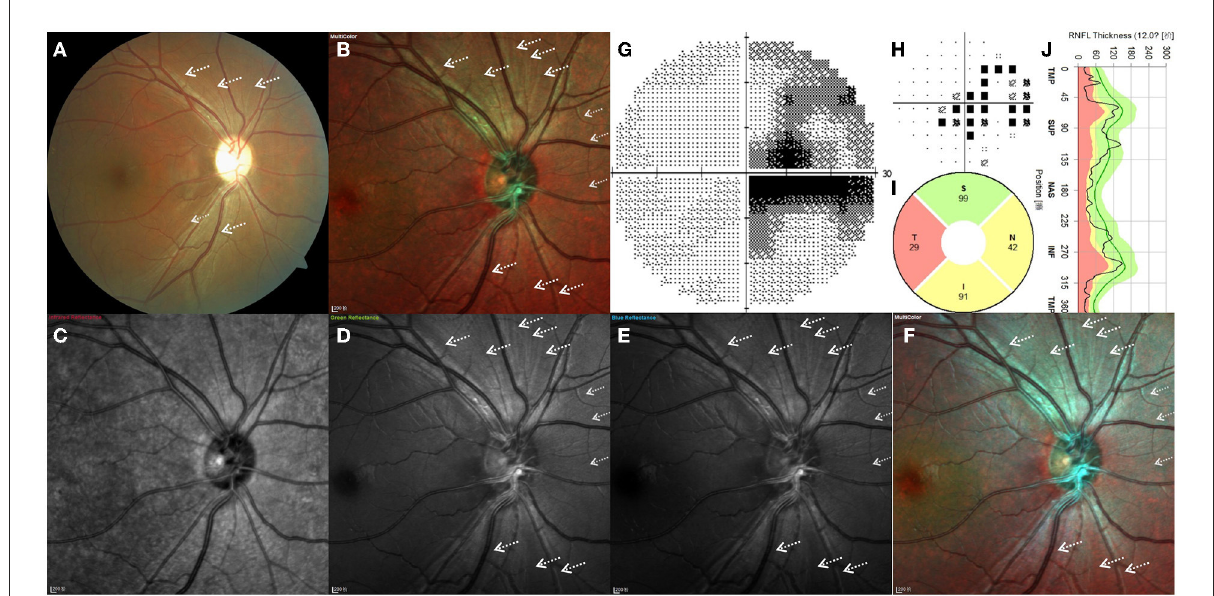
FIGURE2 (A–J) Right eye of a 28.4-year-old Leber hereditary optic neuropathy patient with the G11778A mutation. White arrows indicate the positions of retinal nerve fiber layer